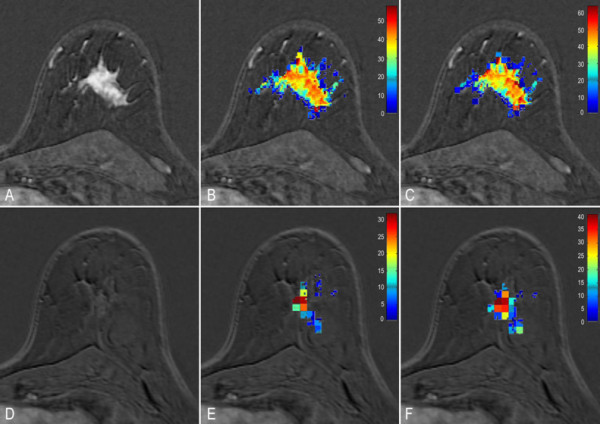
Images show changes in volume leakage (Ve) in patient 10 non responder to neoadjuvant chemotherapy (Sataloff grade C). Columns show in A and D: anatomic subtraction images; in B and E: corresponding Ve map acquired using measured Arterial Input Function (AIF); and in C and F: corresponding Ve map acquired using theoretical AIF. Images A, B, and C show data before neoadjuvant chemotherapy treatment and images D, F, and G are post-treatment. After treatment, low decreases in Ve median were seen using the measured AIF (-59%) and theoretical AIF (-50%) in agreement with the pathological observation. Note the disagreement with tumour size changes (-100%). To increase visibility of the color encoded Ve pixels the scale was reduced in postchemotherapy images.